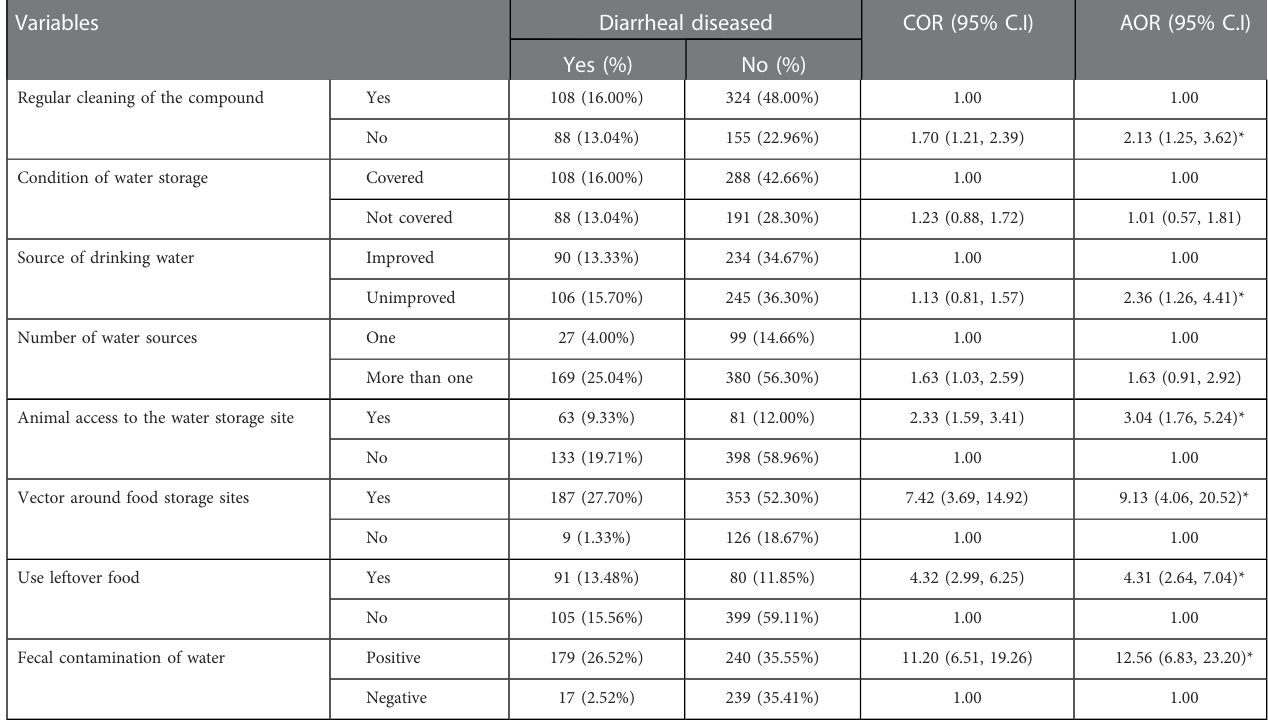
TABLE 1 Multivariable analysis of predictors for diarrhea in children under fi ve living in fl ood-prone areas in Fogera and Libokemkem districts, Northwest Ethiopia, 2021 ( n =675).